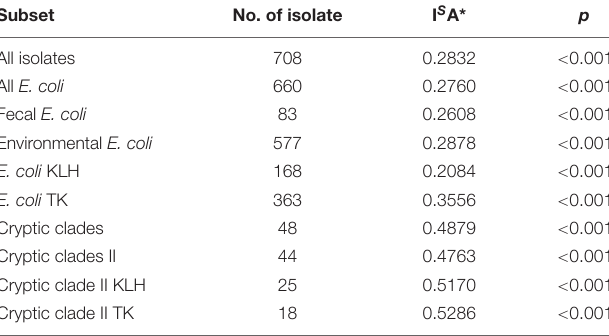
TABLE 5 | Test of linkage